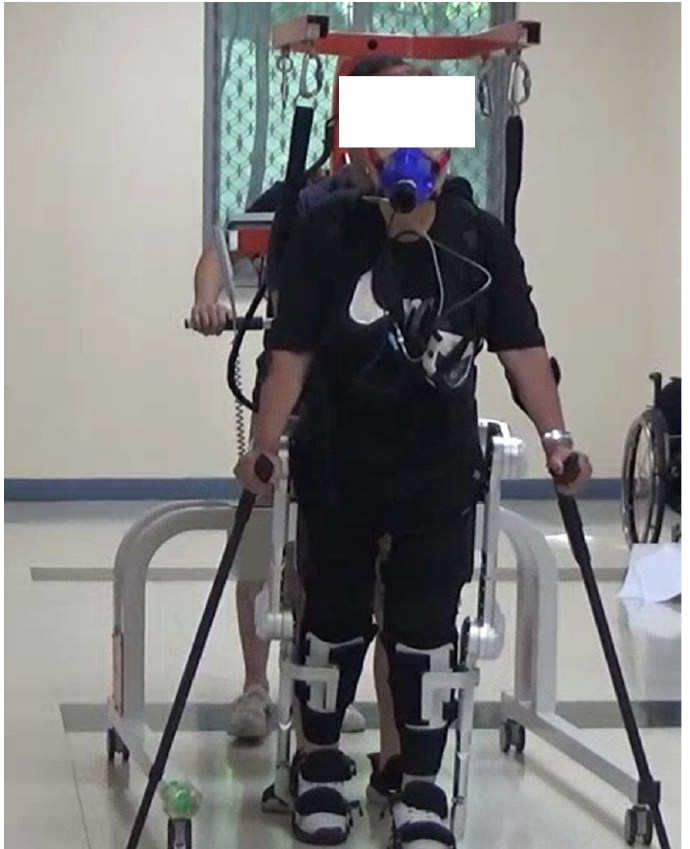
Figure 1. Exoskeleton ‐ assisted overground walking with a portable gas analyzer.